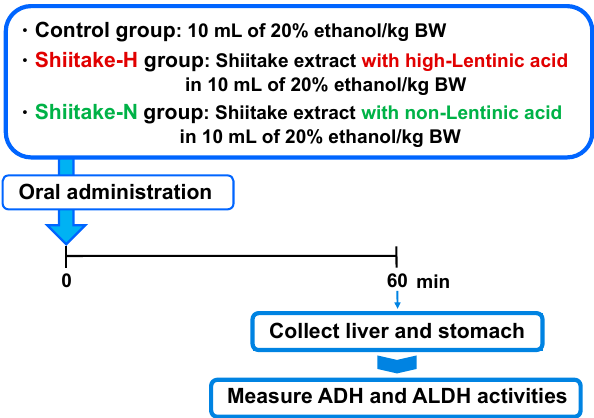
Figure 3. Experimental design to evaluate the effect of shiitake extracts on alcohol dehydrogenase (ADH) and aldehyde dehydrogenase (ALDH) activities.